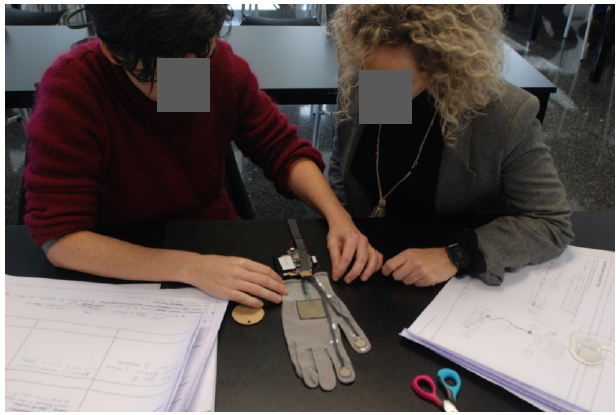
Figure 16. Participants from Group 2 completing the templates.